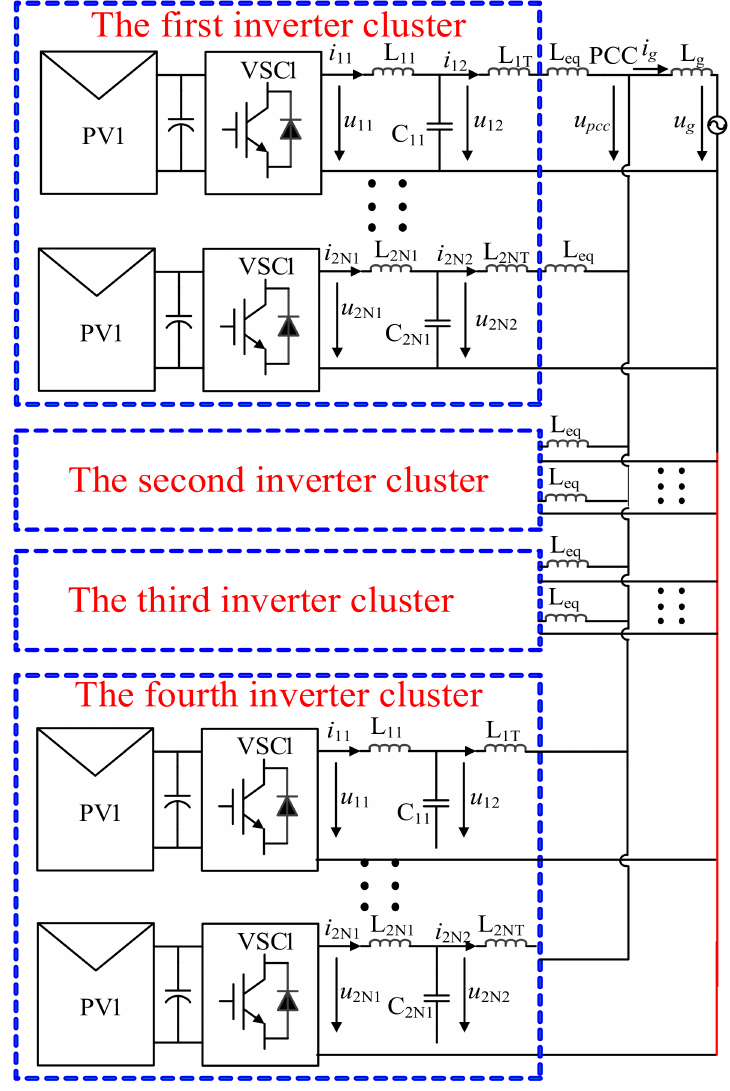
Figure 4. Equivalent circuit diagram of the 200 MW photovoltaic power station.